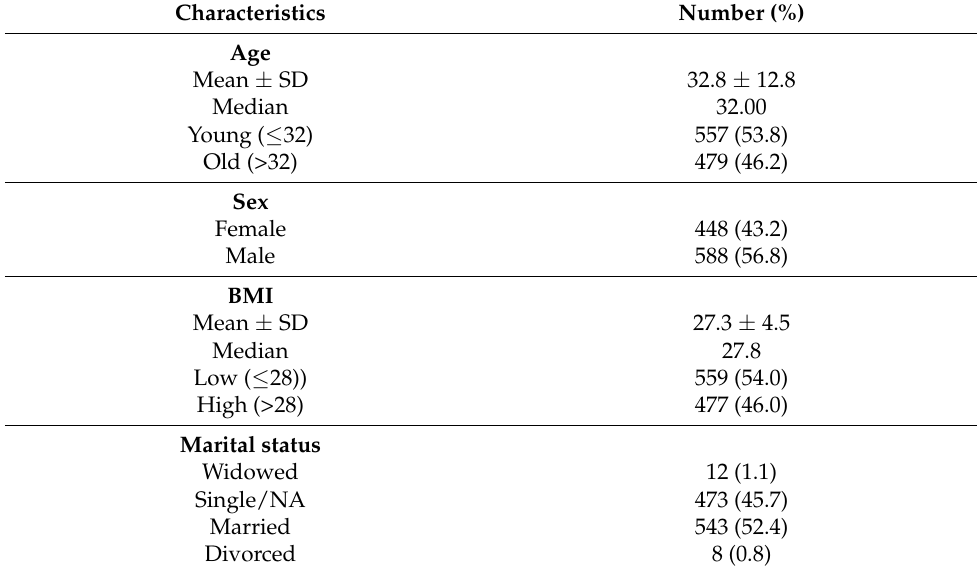
Table 1. Baseline characteristics of